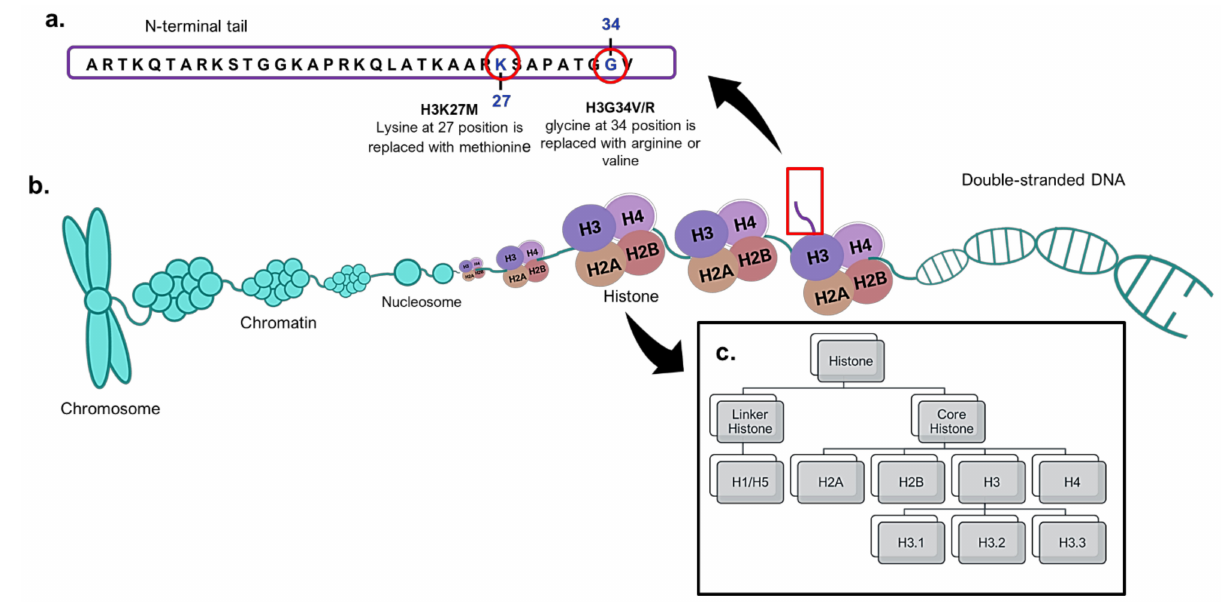
Figure 2. Structure of histone and histone H3 mutations. ( a ) Histone H3 mutations (H3K27M and H3G34V/R) at the N-terminus of H3. ( b ) Histones pack human DNA to form nucleosomes and chromatins. ( c ) Types of histones and